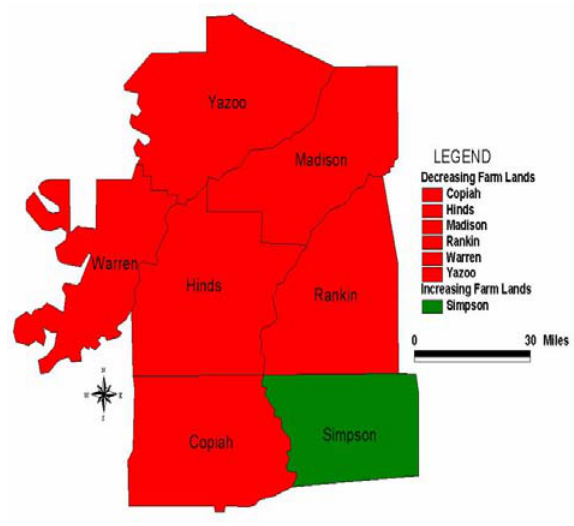
Figure 2.3: Changes in Farmland Acreage, From 1987- 1997.